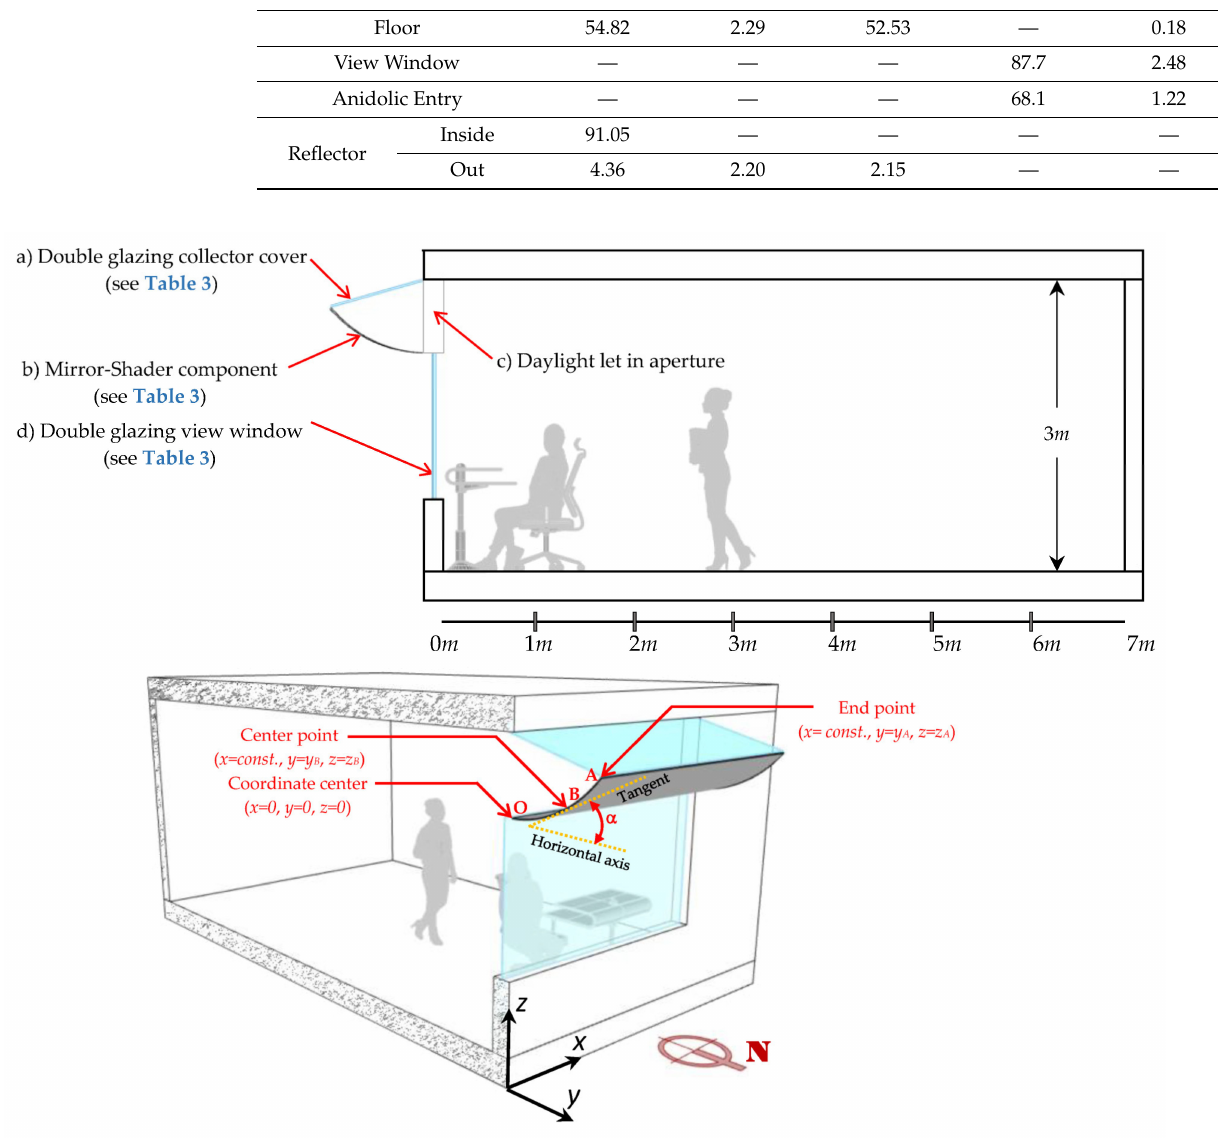
Figure 4. ADS components, elements, and parameters to be